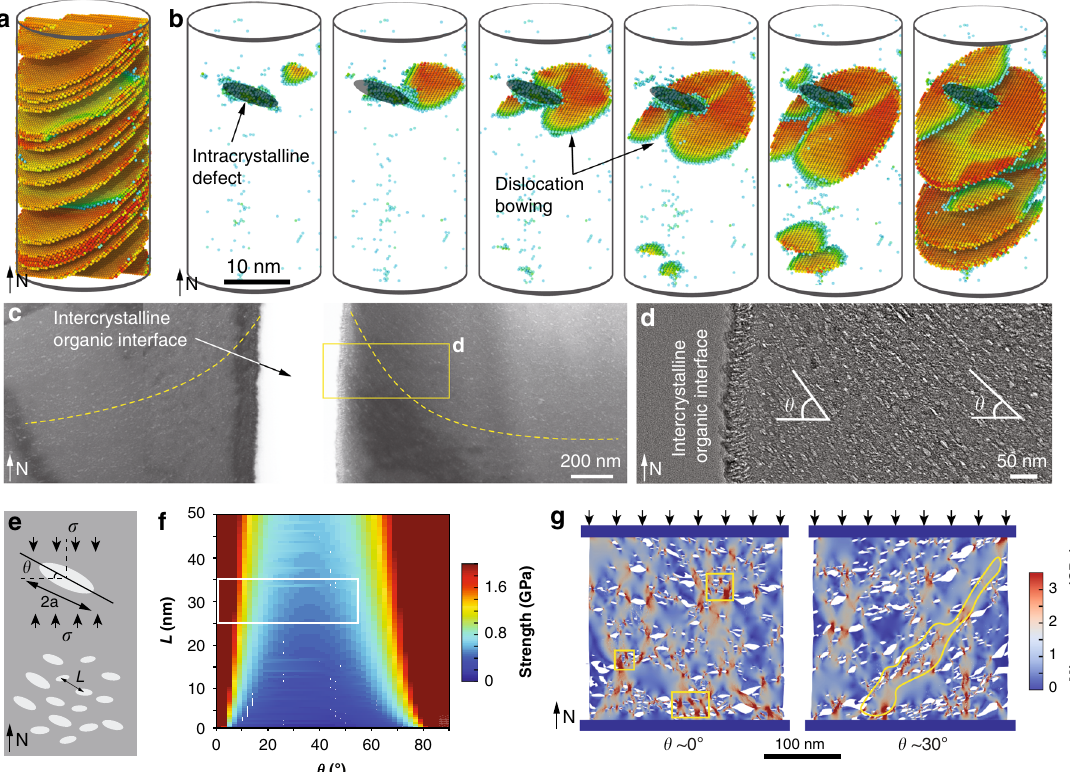
Fig. 6 Mechanical effects of intracrystalline defects in A. rigida biogenic calcite. a , b Atomistic simulation of compression on a geological and b the biogenic calcite along the c axis, respectively. c , d TEM images showing that the orientation of the intracrystalline defects is gradually tilted towards the intercrystalline organic interfaces. The yellow dashed lines in c indicate the long-axis direction of defects locally. e Schematic model of the biogenic calcite with the presence of intercrystalline defects. f Estimated strength in relation to the spacing ( L ) and the inclination angle ( θ ) of intracrystalline defects. The boxed region highlights the actual con fi gurations of defects observed in the A. rigida biogenic calcite. g Comparison of the stress contours and fracture patterns of biogenic calcites with defects orientations θ = ca. 0° and ca. 30° based on fi nite element/discrete element simulation. The boxed regions in the θ = ca. 0° model show cracks initiated at regions with a high density of defects, and the yellow region highlights an inclined damage band formed in the θ = ca. 30°